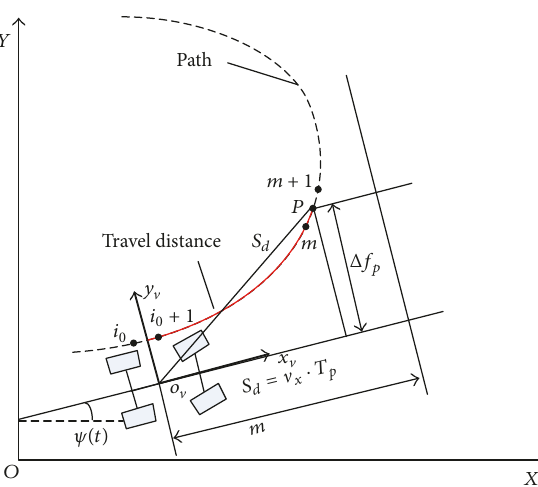
Figure 7: Method of tracking a path with a large amount of curvature.